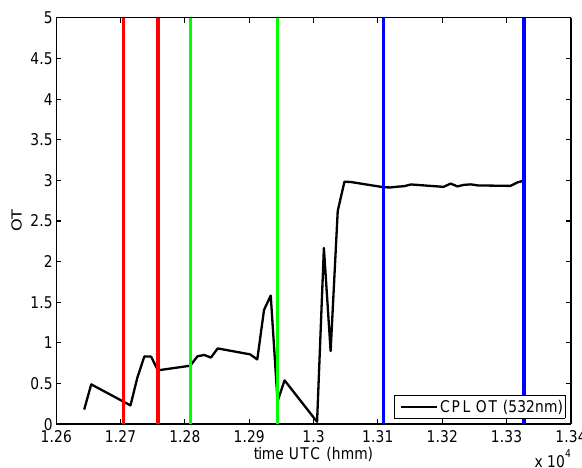
Fig. 10. CPL retrieved cloud total optical depth for the ER-2 flight leg from 01:26 to 01:34UTC, 23 February 2003. The vertical coloured lines delimitate the three sectors selected for the compar-